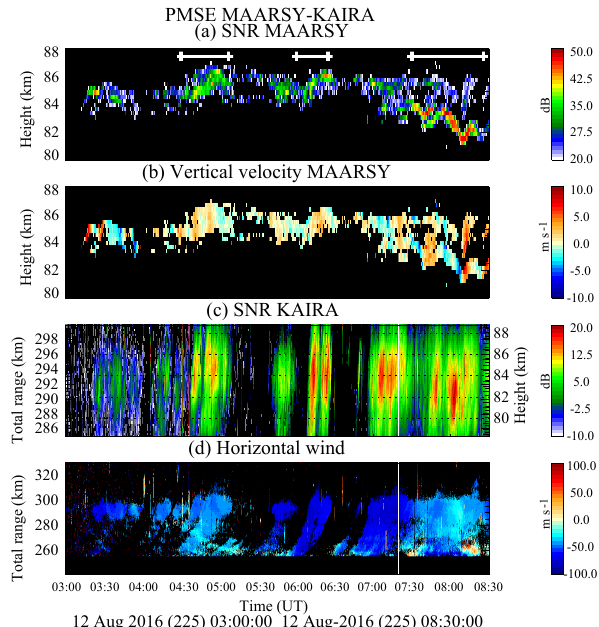
Figure 7. Derived PMSE parameters from combining MAARSY and KAIRA observations, using a SNR threshold of 30dB in MAARSY observations: (a) vertical structure, (b) vertical velocity, (c) vertical structure as observed from KAIRA, and (d) horizon- tal velocity along MAARSY–KAIRA direction (positive towards KAIRA). Approximate distances of 100km are indicated in panel (a) with white lines. See text for